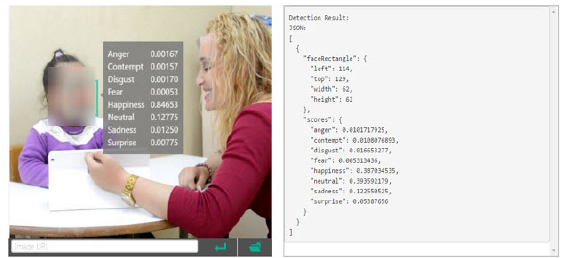
Figure 1. Emotion Detection API Anal- ysis Screen